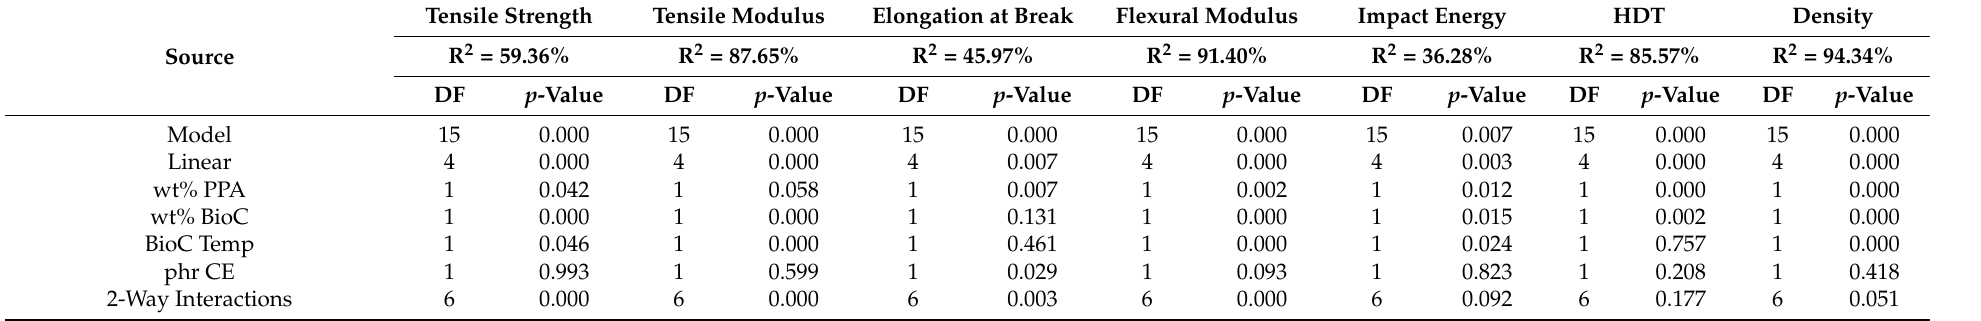
Table 2. Degrees of freedom, p -values, R 2 fit of model for the mechanical